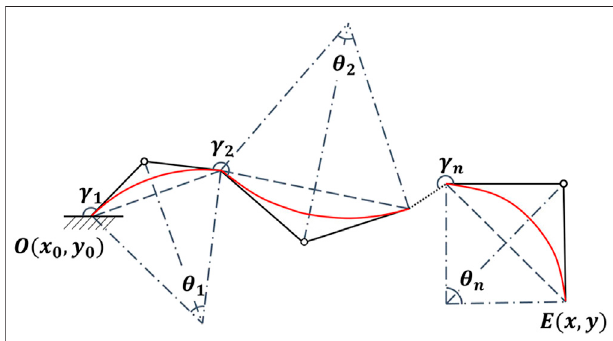
FIGURE 4 | Geometric decomposition of 4D deformed beam into n arc